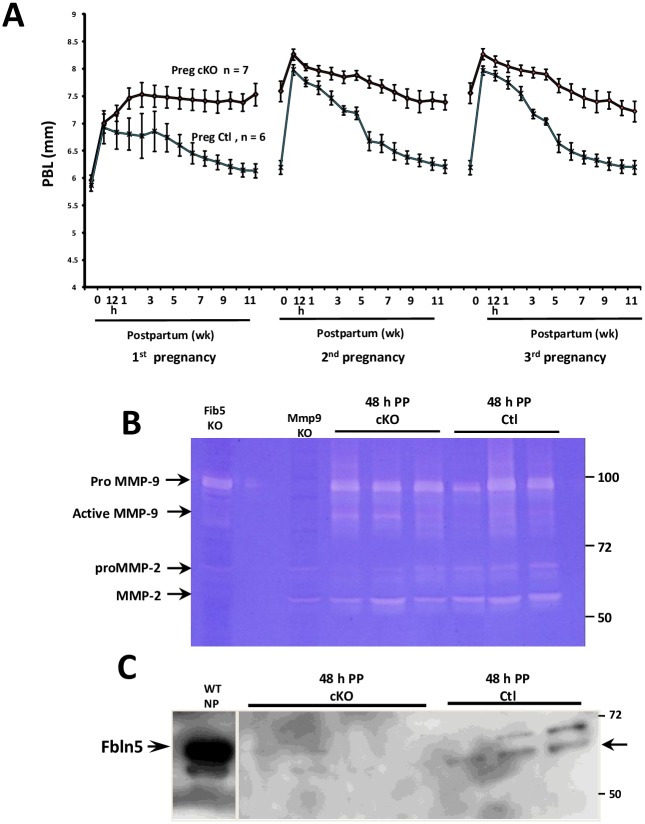
Effect of pregnancy and vaginal delivery on Fbln5 cKO mice.A. Perineal body length was measured at time 0 (prior to pregnancy) and 12 h to 12 wks postpartum in Fbln5f/f/SMA++/Cre+ (Preg cKO, n = 7) and Fbln5f/f/SMA++/Cre- mice (Preg Ctl, n = 6) during 3 pregnancies. B. Gelatin zymography of vaginal tissue extracts from Fbln5f/f/SMA++/Cre+ (cKO) and Fbln5f/f/SMA++/Cre- (Ctl) mice 48 h postpartum. Vaginal tissue extracts from Fblin5-/- (Fib5 KO) and Mmp9-/- (MMP9 KO) mice were used as positive and negative controls. Lane 2 is blank. C. Immunoblot of Fbln5 in urea extracts of vaginal muscularis from wild type nonpregnant control (WT NP), cKO, and Ctl animals 48 h postpartum. Arrow denotes cleaved form. All animals were treated with doxycycline at 6 weeks of age, mated, and tissues collected after the first pregnancy.